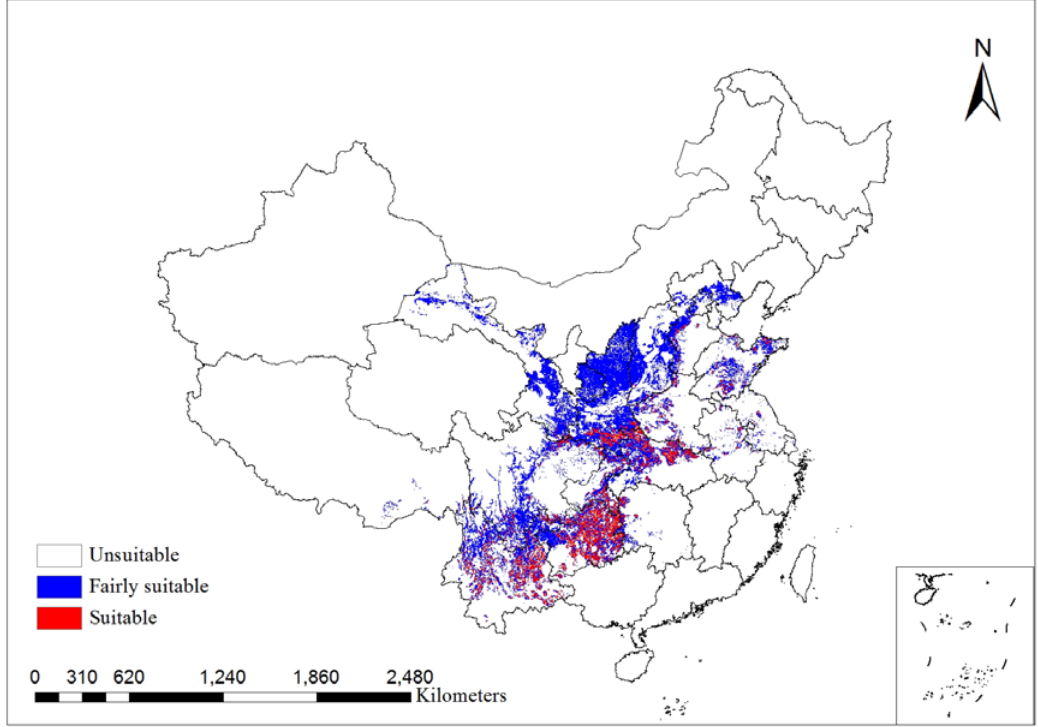
Figure 2. Spatial distribution of marginal land suitable for Pistacia chinensis in